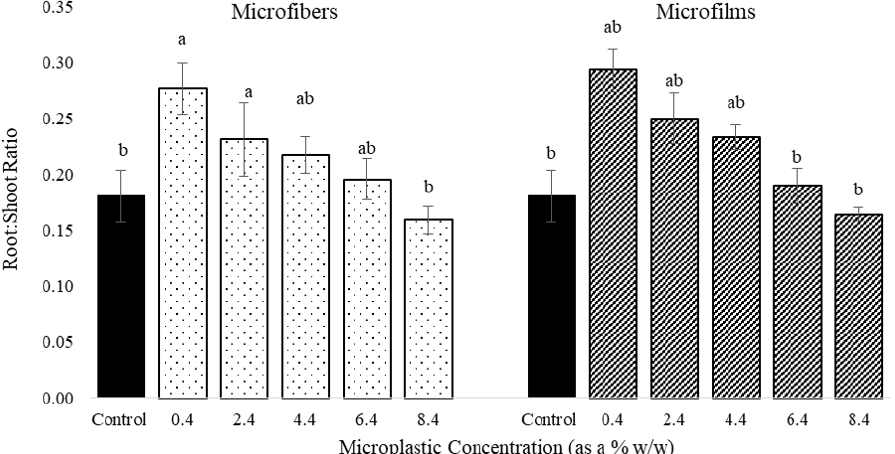
Figure 3: Root: shoot ratio of tomato seedlings after 13 wk of growing in different dosages of microfilms and microfibers. Error bars indicate the standard error of the mean value (SEM). Different letters indicate the significant difference between means at a significance level of <